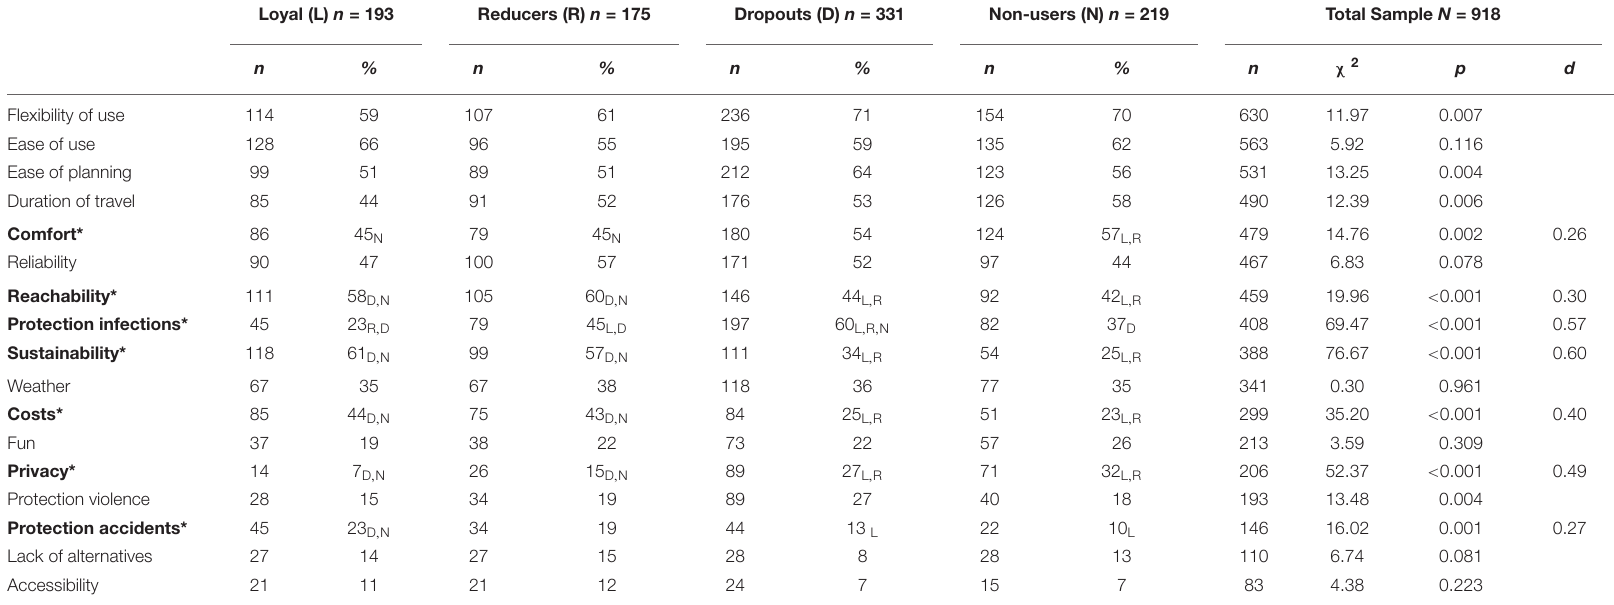
TABLE 3 | Criteria of transport mode choice as selected by the four target